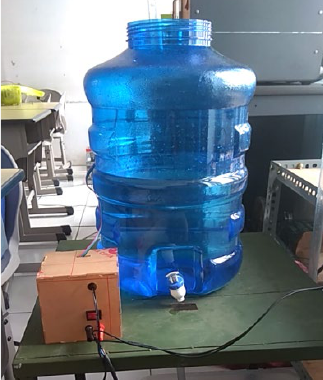
Figure 23. Android display during the second test